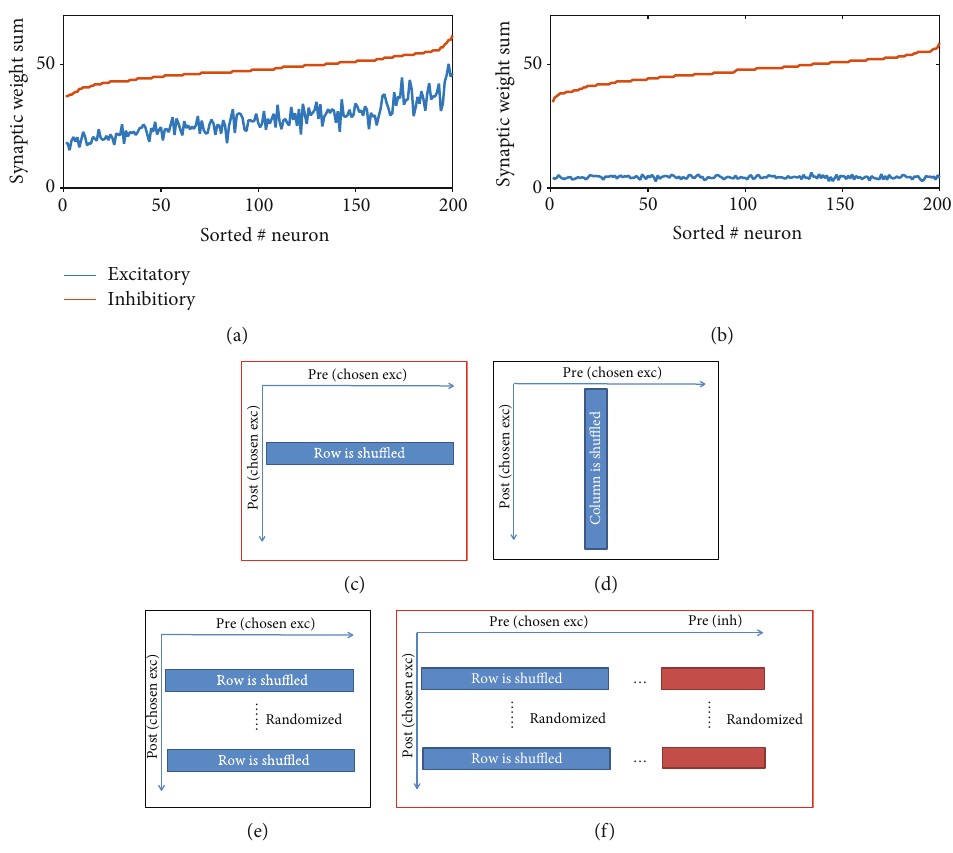
Figure 7: Special circuit structures formed by plasticity. (a, b) The relation between the sums of incoming excitatory and inhibitory synaptic weight of di ff erent neurons in the plastic circuit after learning, sorted according to the ascending order of inhibitory weight sum. Parameters are set as τ I = 8ms, As = 3 : 5 . (a) Synchronous with τ E = 6ms . (b) Asynchronous with τ E = 90ms . (c – f) Illustration of shu ffl ing schemes. Each d d d fi gure represents a connectivity matrix. In (c – e), we shu ffl ed the elements of the connectivity sub-matrix of the chosen excitatory neurons (to encode the memory). (c) The input elements of each neuron (each row) are shu ffl ed (total input is preserved). (d) The output elements of each neuron (each column) are shu ffl ed (total input is changed). (e) The elements of each row are fi rst shu ffl ed and then the row is randomly shu ffl ed (total excitatory input is preserved, but total inhibitory input is changed). The shu ffl ing scheme of (f) the elements of each row of the submatrix of excitatory neurons is fi rst shu ffl ed, and then, the row of the entire matrix is randomly shu ffl ed (total excitatory and inhibitory input are preserved). If the shu ffl ed matrix results in synchronous/asynchronous dynamics, then it is marked in a red/black